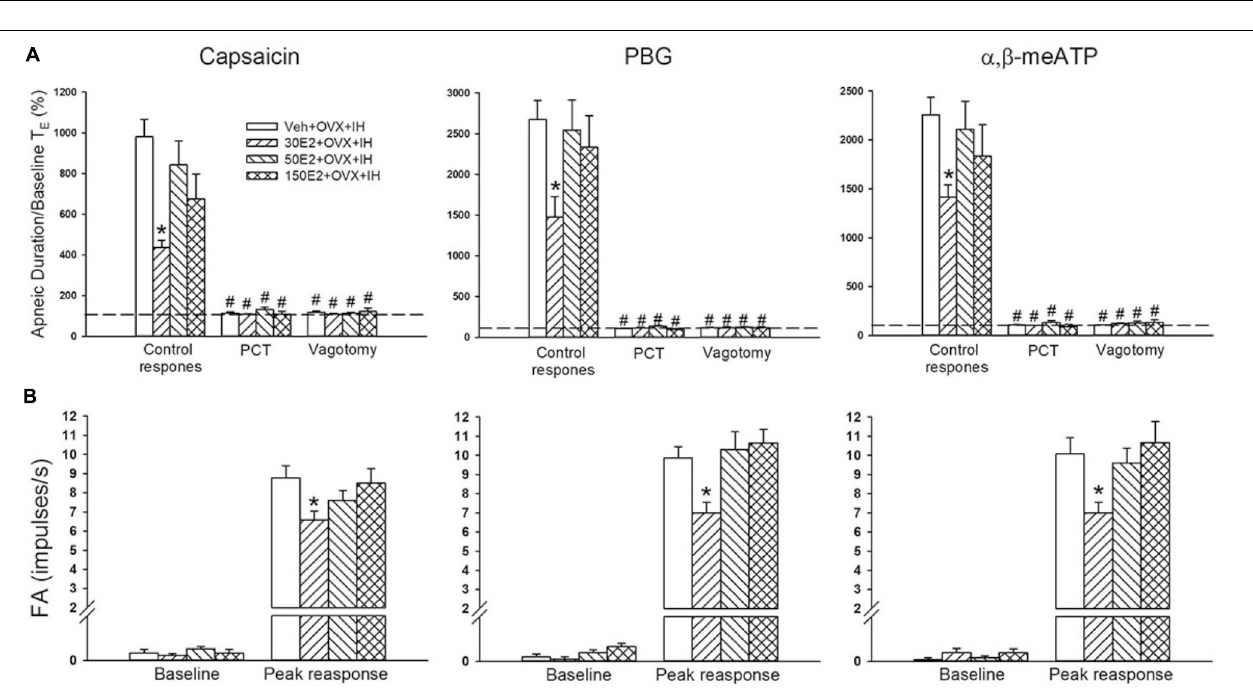
FIGURE 4 | Sensitizing effect of IH on afferent responses of lung vagal C fibers to intravenous stimulants in female rats. Groups of intact rats were exposed to RA or IH for 14 days, and OVX rats were exposed to IH (OVX + IH) for the same duration. The afferent responses (fiber activity, FA) to intravenous capsaicin (A) , PBG (B) , and α , β -meATP (C) were measured. Baseline FA was calculated as the value averaged over 10-s interval before stimulation. The peak response was measured as the maximum averaged over 2-s interval after stimulation. Except for the RA group, which included rats in the four stages of the estrus cycle ( n = 6/each stage; total number of RA rats: 24), all data from the other groups are presented as means ± SE of 10 fibers recorded from 10 rats. ∗ p < 0.05 compared with peak responses of RA rats; # p < 0.05 compared with peak responses of IH rats. See the legend of Figure 1 for further explanation.